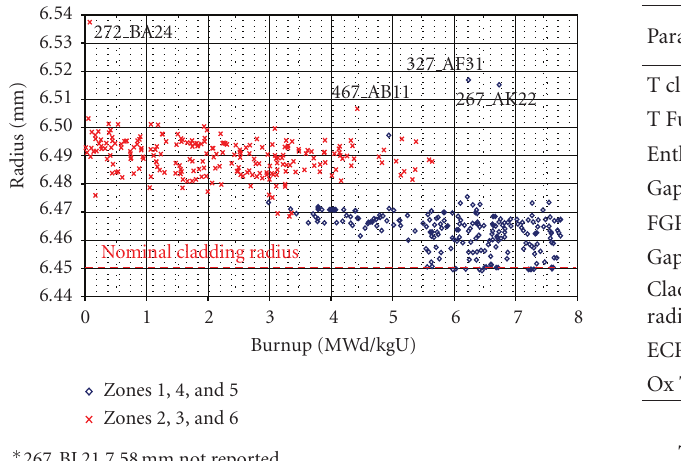
Figure 13: Cladding outer radius as a function of gap pressure.